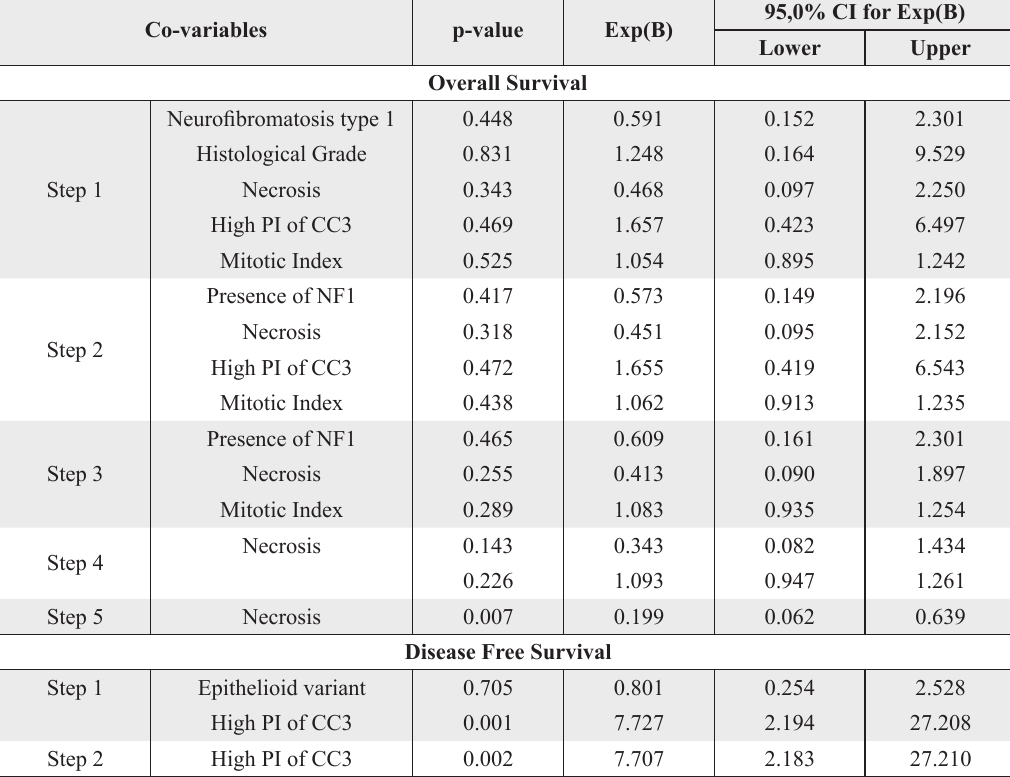
Results of the Cox regression model for significant variables in univariate analysis for overall and disease free